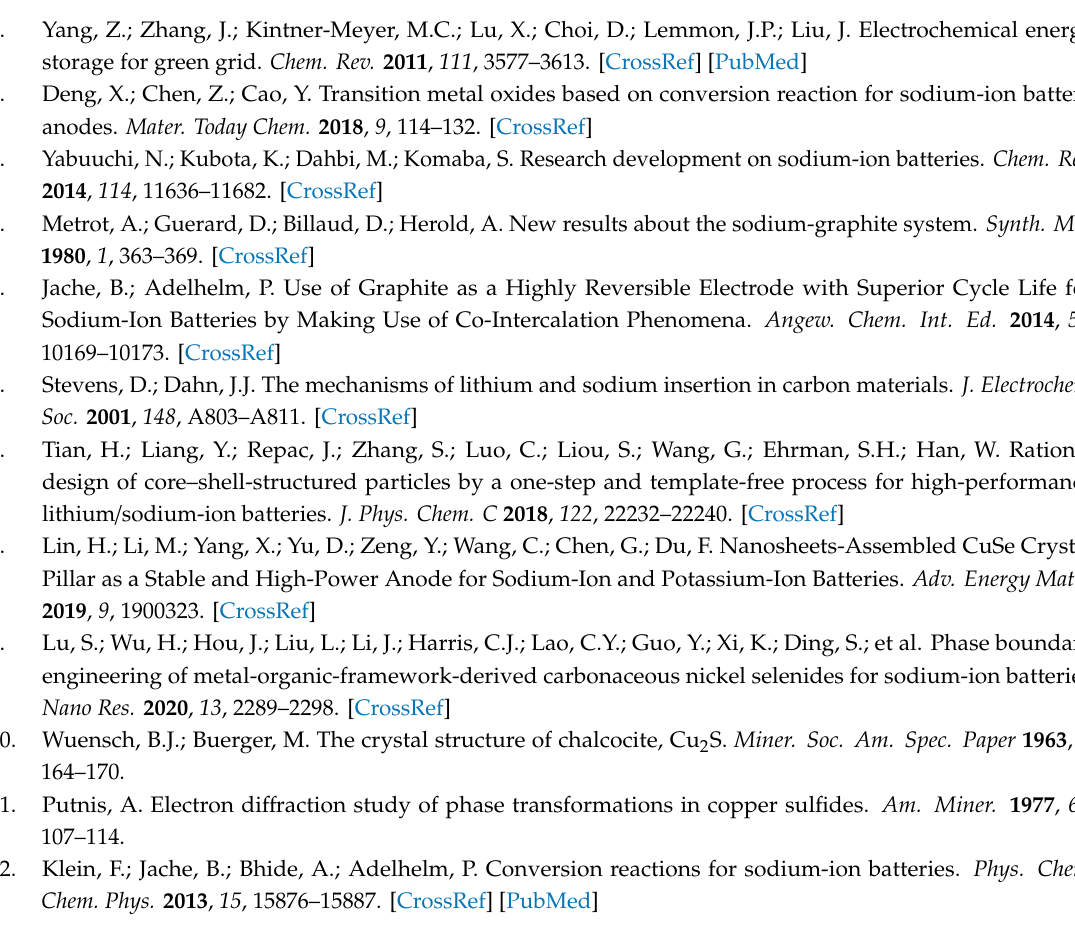
Figure S1: High-magnification SEM images of ( a ) bare and ( b ) Al 2 O 3 -coated (80 cycles) NG and ( c ) bare and ( d ) Al 2 O 3 -coated (80 cycles) Cu 2 S demonstrate the uniformity and conformity of ALD coating on electrode materials. EDX element mapping of Al 2 O 3 -coated ( e ) NG and ( f ) Cu 2 S reveals the contents of Al as the Al 2 O 3 coating, Figure S2: Cycling performance of a Na-NG half-cell, delivering 84 mAh g − 1 capacity at 100th cycle. Figure S3: Nyquist plots from EIS measurements of ALD-coated Cu 2 S@NG electrodes with (a) 1, (b) 2, (c) 4, (d) 6, and (e) 8 nm Al 2 O 3 coatings during 5 cycles. (f) The physical model used for fitting EIS data, Table S1: Summary of electrode loading and battery performance in all previously reported literature and this study, Table S2: The fitted EIS data for Cu 2 S@NG and ALD-coated Cu 2 S@NG at